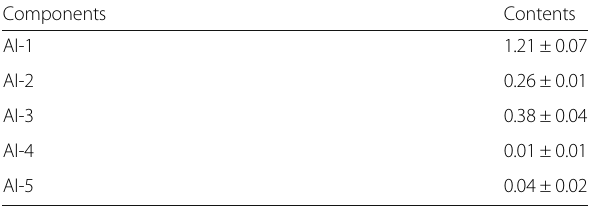
Table 8 The contents (mg/g) of AI-1~5 weight by HPLC